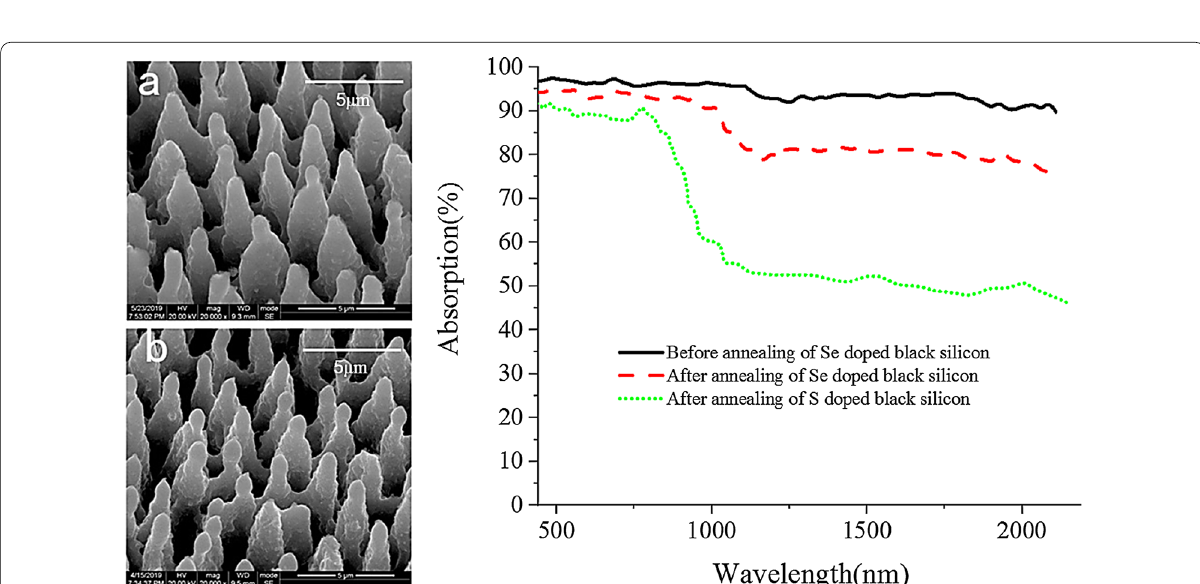
Fig.6 The changes of the surface morphology and photoelectrical properties of material after high-temperature